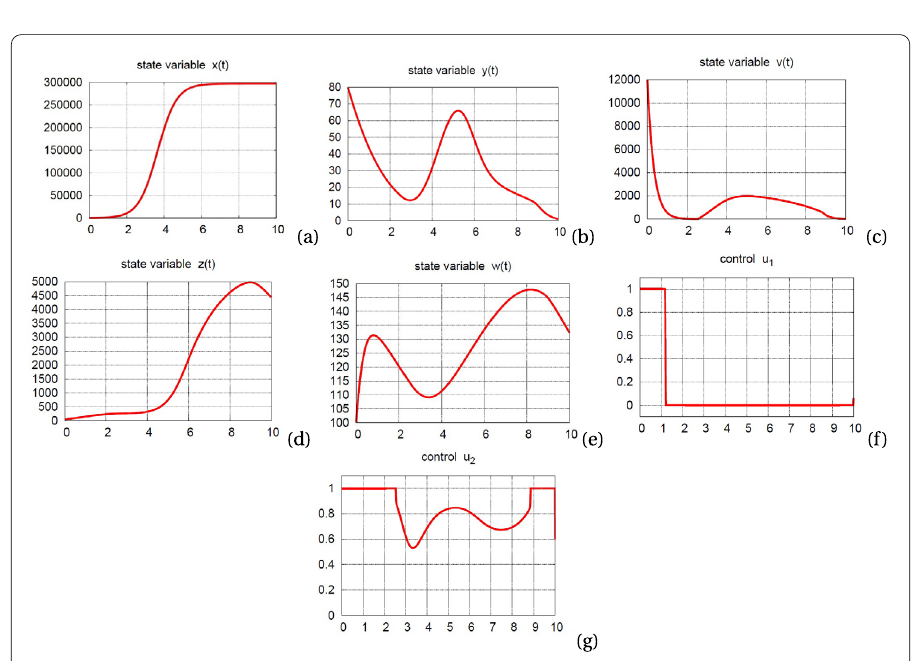
Figure 4 ( a ) Saturation level of uninfected CD + 4 T-cells with optimal control for Column 6 of Table 2 ( b ) Level of infected CD + 4 T-cells with optimal control for Column 6 of Table 2 ( c ) level of viral load with optimal control for Column 6 ( d ) level of T-cells with optimal control for Column 6 of Table 2 ( e ) level of B-cells with optimal control for Column 6 of Table 2 ( f ) Behavior of optimal control, u ∗ 1 as protease inhibitor for Column 6 ( g ) Behavior of optimal control, u ∗ 2 as reverse transcriptase inhibitor for Column 6 of Table